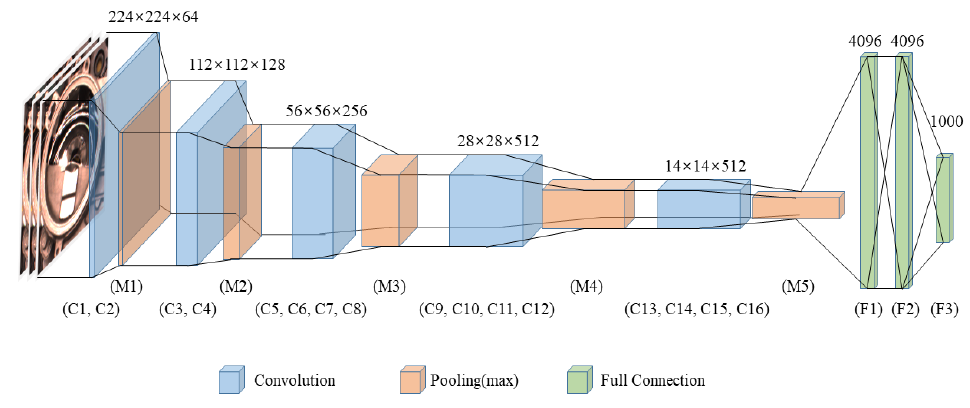
Figure 10. VGGNet-19 structure.